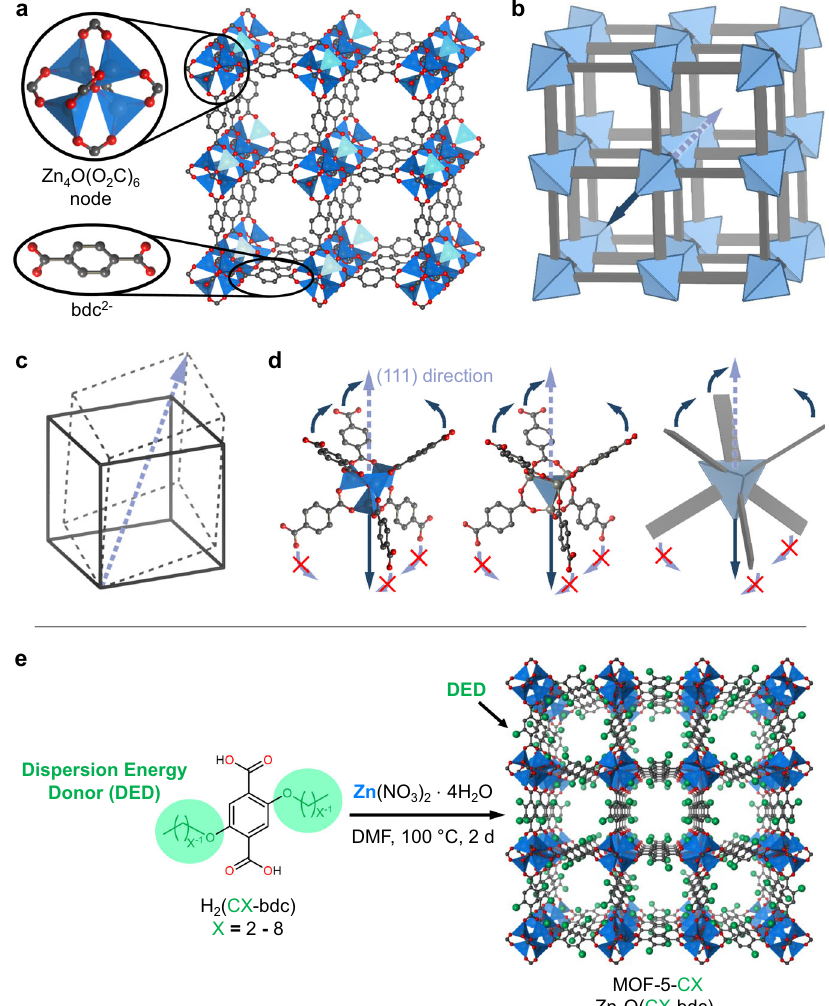
Fig. 1 Structure and geometrical constraints of the MOF-5 structure type. a Crystal structure of MOF-5 (CCDC deposition code 256965). Zn, O and C atoms are shown in blue, red and grey, respectively. H atoms are omitted. b Simpli fi ed building block representation of the structure of MOF-5. c Rhombohedral distortion of a cube along its body diagonal. d Abstraction path of the actual chemical structure towards the respective geometries of its building units as shown in the simpli fi ed building block representation ( b ). Arrows symbolize the required movements of these building units (that is, [Zn 4 O] 6 + and bdc 2 – ) in case of the rhombohedral distortion. e Schematic for the preparation of alkoxy-functionalized MOF-5-CX derivatives. Dispersion energy donors (DEDs) are marked as green spheres. The atom colour code is the same as in (